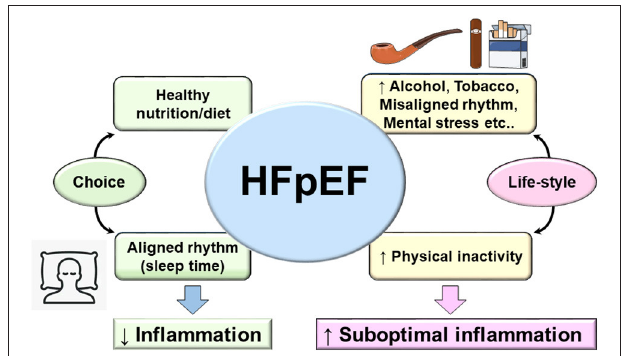
FIGURE 3 | Fundamental and lifestyle-associated prime factors that control inflammation (left arm of figure) in contrast to risk factors that drive suboptimal inflammation in HFpEF and integration with lifestyle-associated molecular patterns (LAMPs). The main four aspects of daily life to consider as prime strategy for prevention of HFpEF (diet/nutrient, sleep/wake up rhythm, exercise, and choice of active life and limited sedentary lifestyle). Adoption of optimal age-related lifestyle would be helpful to balance the genesis of LAMPs in cardiovascular disease that will help to limit the progression to heart failure.